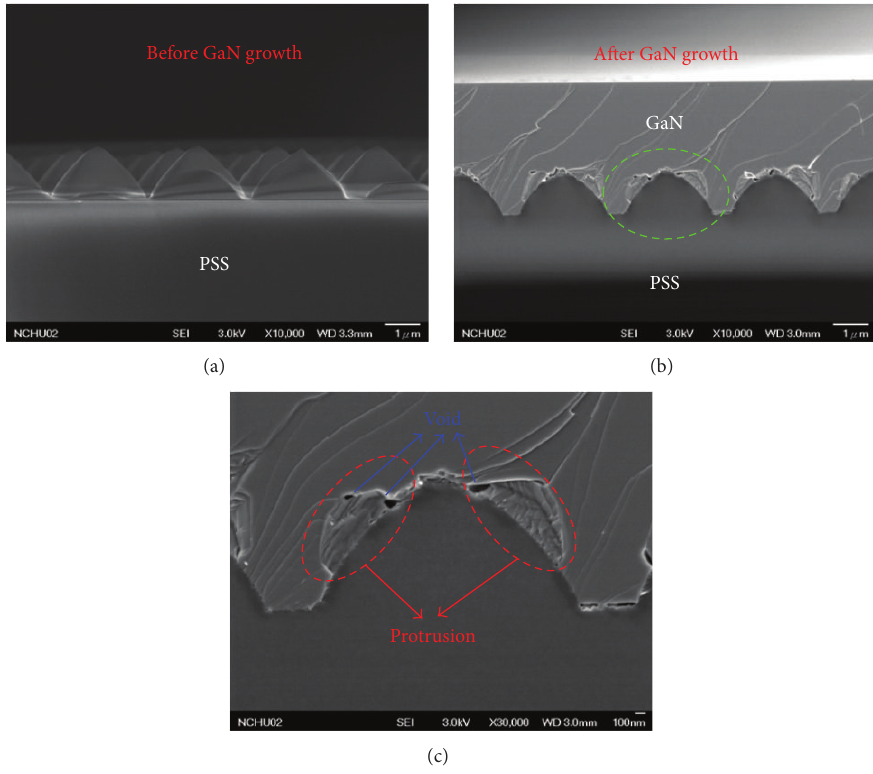
Figure 4: Cross-sectional SEM images (a) before and (b) after epilayer growth on PSS subjected to wet etching for 3 min and (c) SEM image taken at the cone pattern in (b) (marked with green circle) with higher